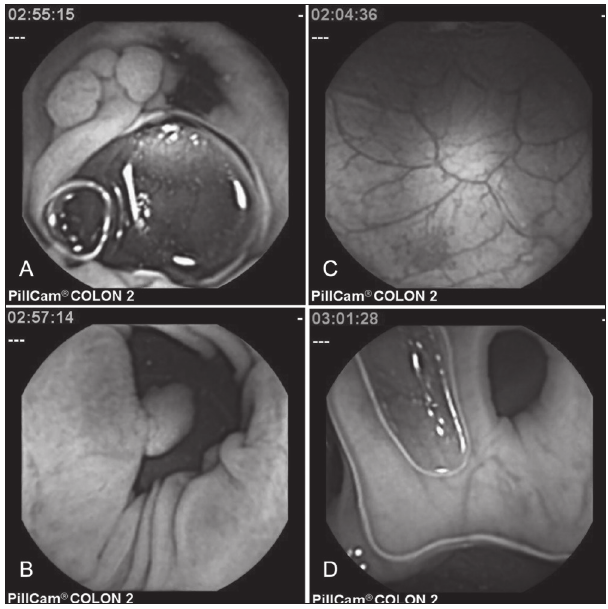
Figure 2) Extracolonic landmarks and findings. Z-line ( A ); papilla of Vater ( B ); small bowel angiodysplasia ( C ); ileic diverticulum ( D